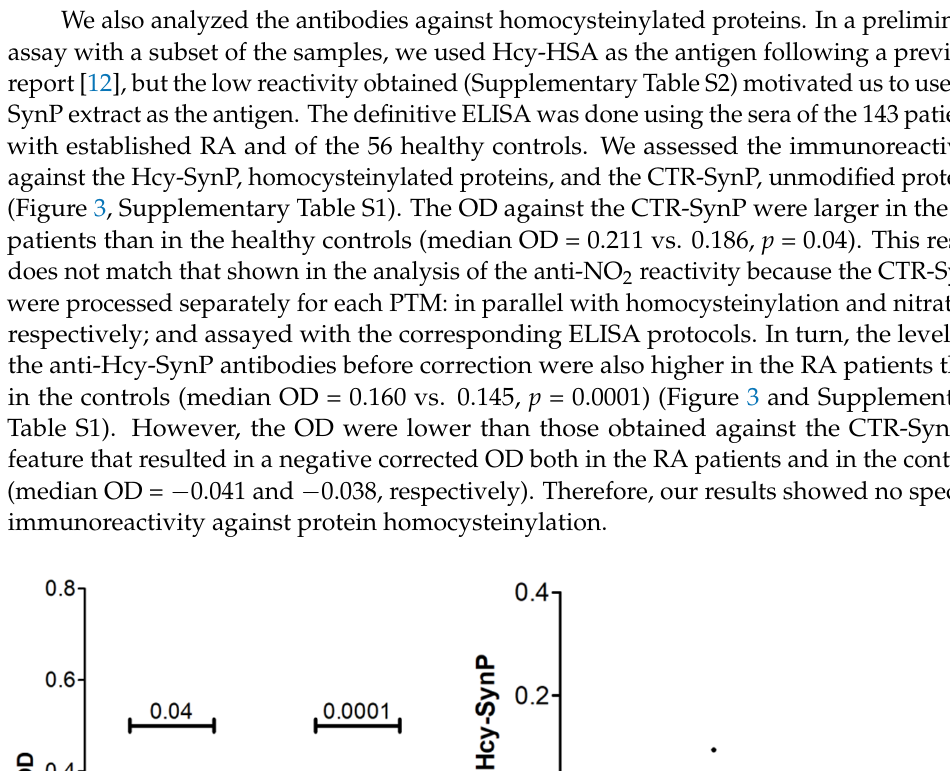
8 of 18 Figure 2. Reactivity against nitrated proteins and peptides in RA patients and healthy controls. ( a ) Uncorrected; and ( b ) corrected OD of the reactivity against NO 2 -SynP; ( c ) uncorrected; and ( d ) cor- rected OD of the reactivity against a 3-NT-pep. The red line represents the median OD value in each group. n.s. = non significant. Because of these results, we completed the study by exploring the reactivity against eight synthetic nitrated peptides (3-NT-pep). These peptides were selected from relevant proteins in RA and for their likelihood of in vivo nitration as described in the Material and